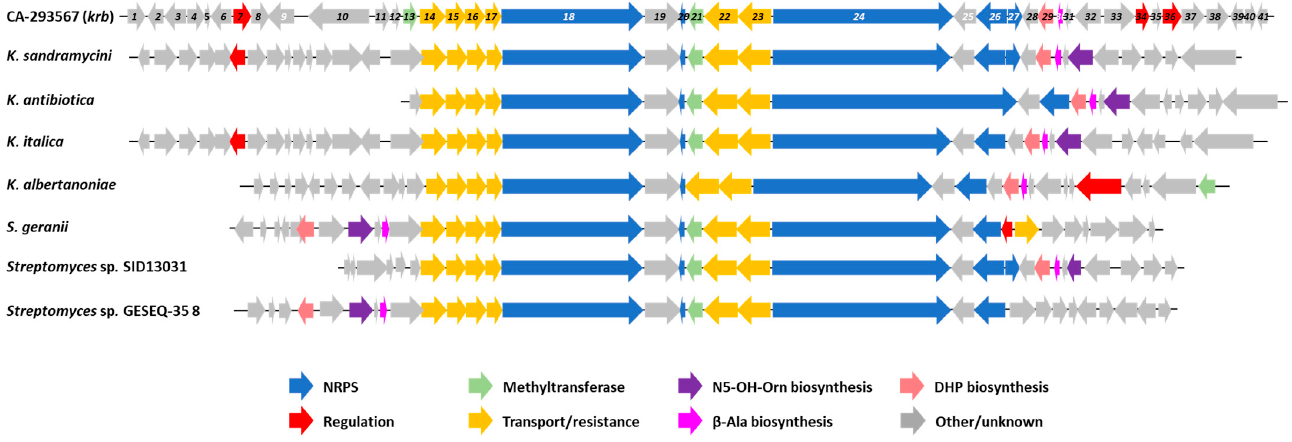
Figure 8. Biosynthetic gene clusters homologous to krb found in publicly available genomes.